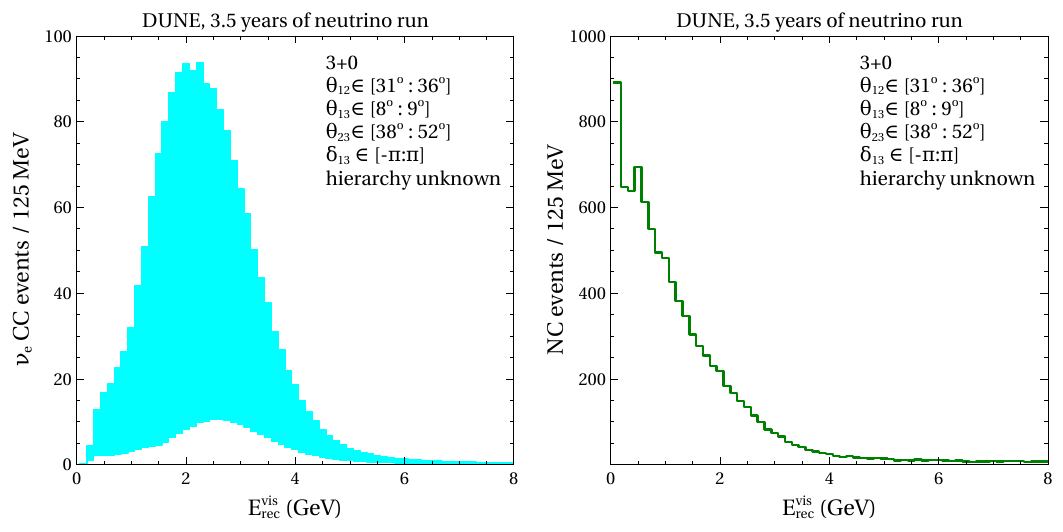
Figure 1 . The left and right panel correspond to (cid:23) e CC and NC events respectively. Here, all parameters are varied in their currently allowed range. E vis energy of the events in the detector. In the case of CC events, it closely matches the true energy of the incoming neutrino. For the NC events, E vis neutrino energy, as we discuss